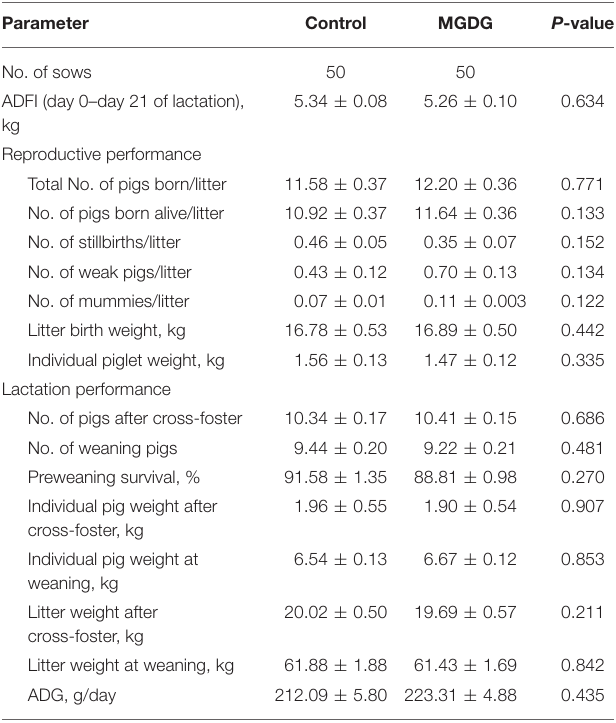
TABLE 3 | Effects of dietary MGDG supplementation during late gestation and lactation on sow reproductive and lactation performance.